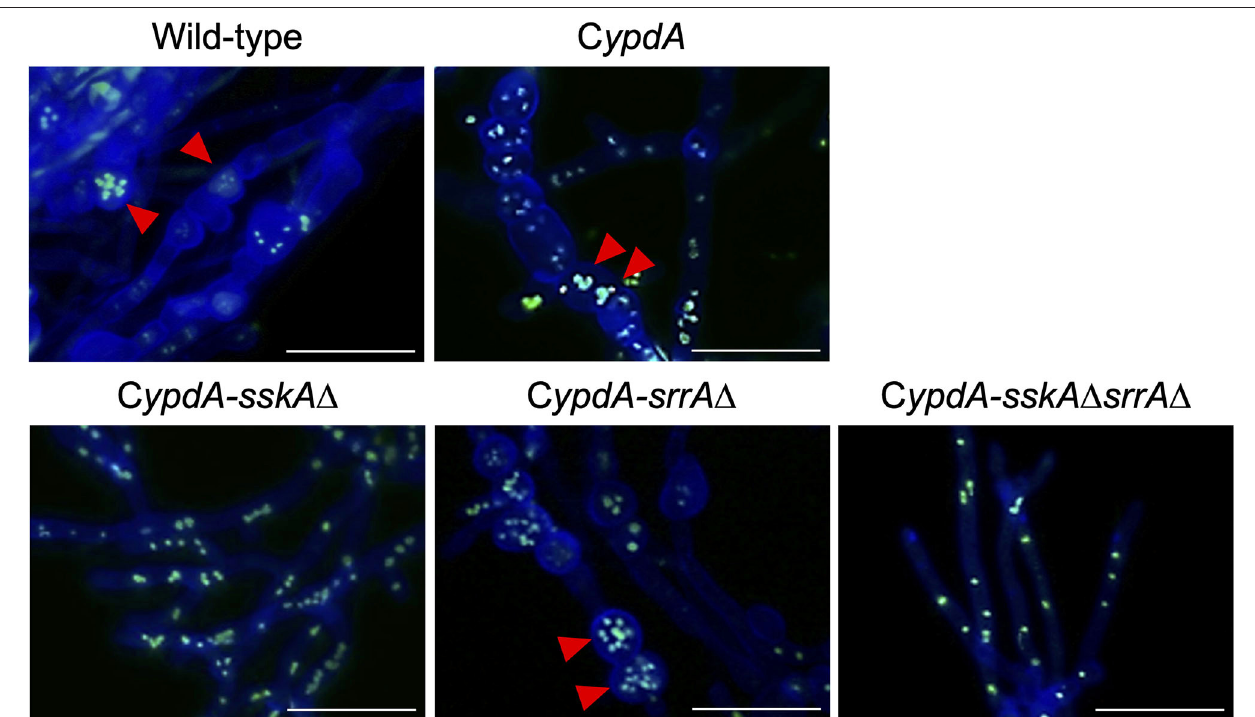
FIGURE 9 | Morphology of hyphae and nuclei under ypdA -inducing + 0.1 µ g/ml fludioxonil conditions in the wild-type and C ypdA strains. Strains were cultured for 20h in liquid CDTFY ( ypdA -inducing) medium at 37 ◦ C, then transferred to CDTFY medium with fludioxonil (0.1 µ g/ml) and incubated for 16h at 37 ◦ C. Red arrowheads indicate fragmented nuclei. Bars, 35 µ